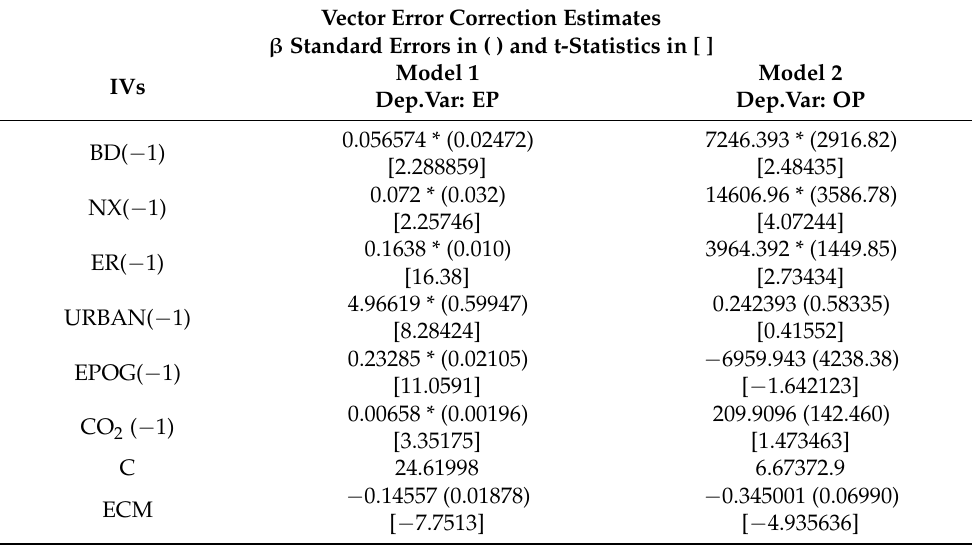
Table 6. Vector Error Correction Long-Run